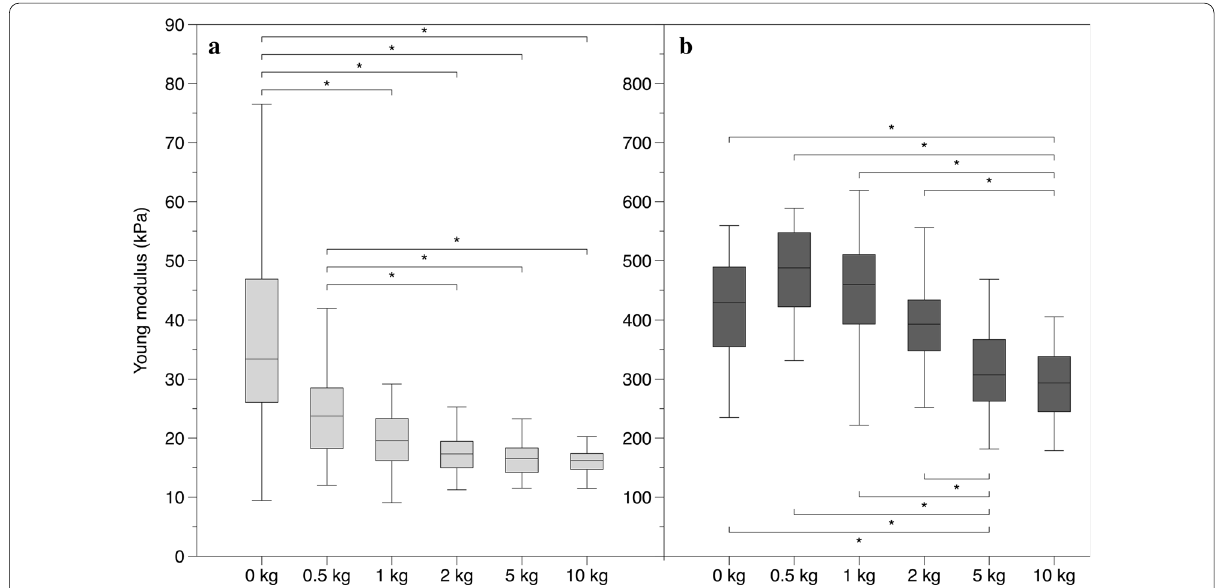
Fig. 4 Shear wave sonoelastography. Box plot showing the median Young’s modulus and IQR values of the entire sample for the different contraction levels a SWE1 and b SWE2. * p < 0.05; statistical significant difference between the different contraction